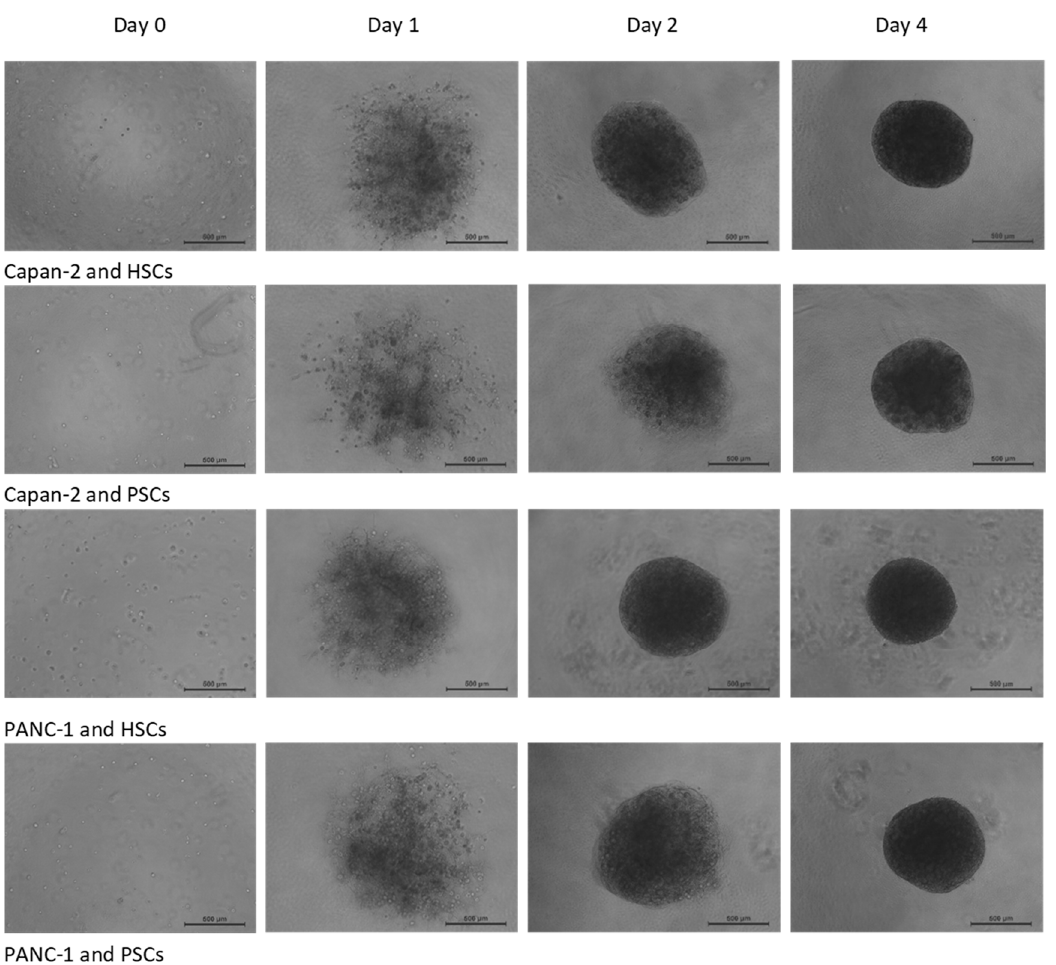
Figure 1. Time-course of 3D spheroid formation: 500 pancreatic ductal adenocarcinoma (PDAC) cells and 1000 hepatic stellate cells (HSCs) or pancreatic stellate cells (PSCs) were mixed in 50 µL of 0.1 mg/mL human type I collagen as indicated. Phase-contrast images were acquired (50× magnification) manually at the indicated time points. Data shown were representative images from at least three independent experiments with at least three spheroids in each experiment. Scale bar: 500 µm.